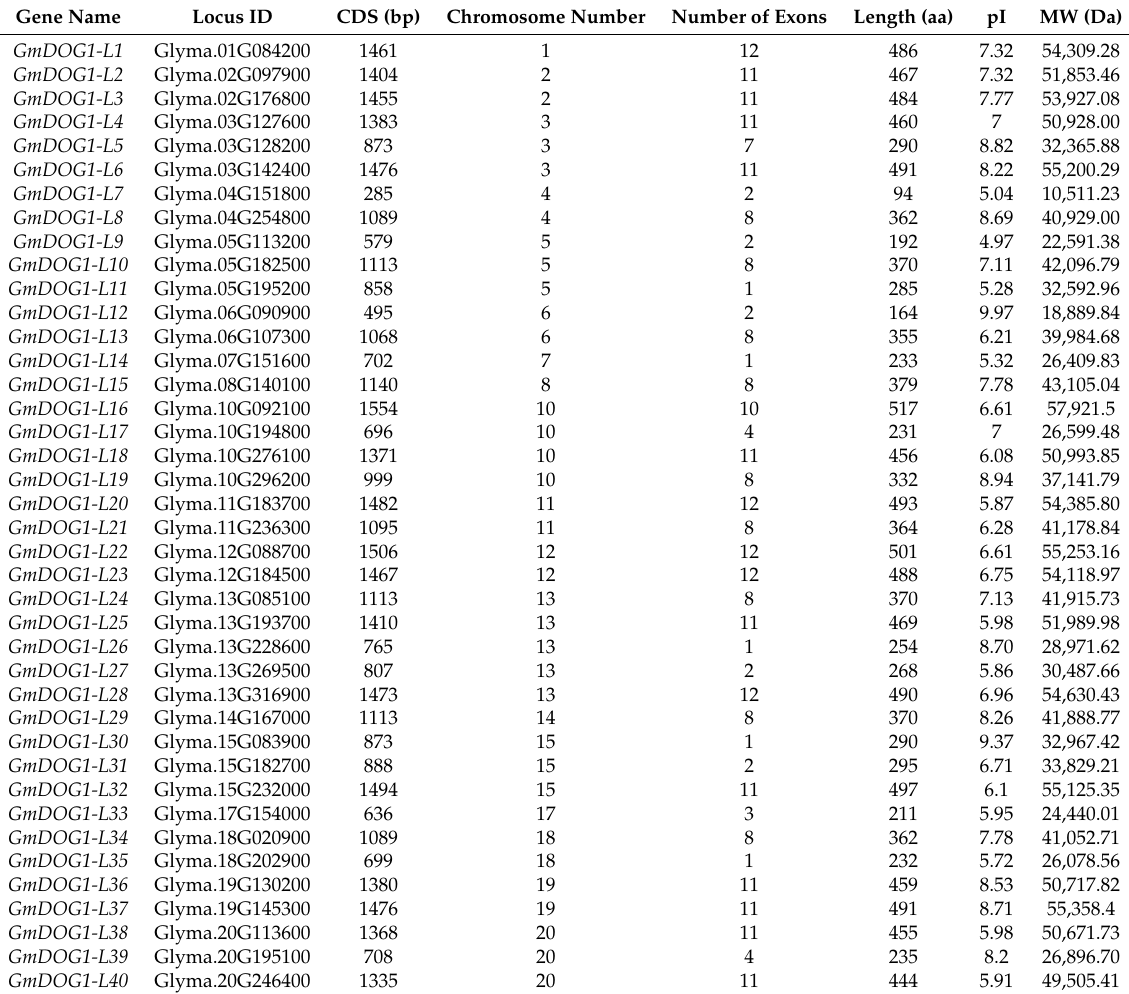
Table 1. Characterization of the GmDOGL1s family in